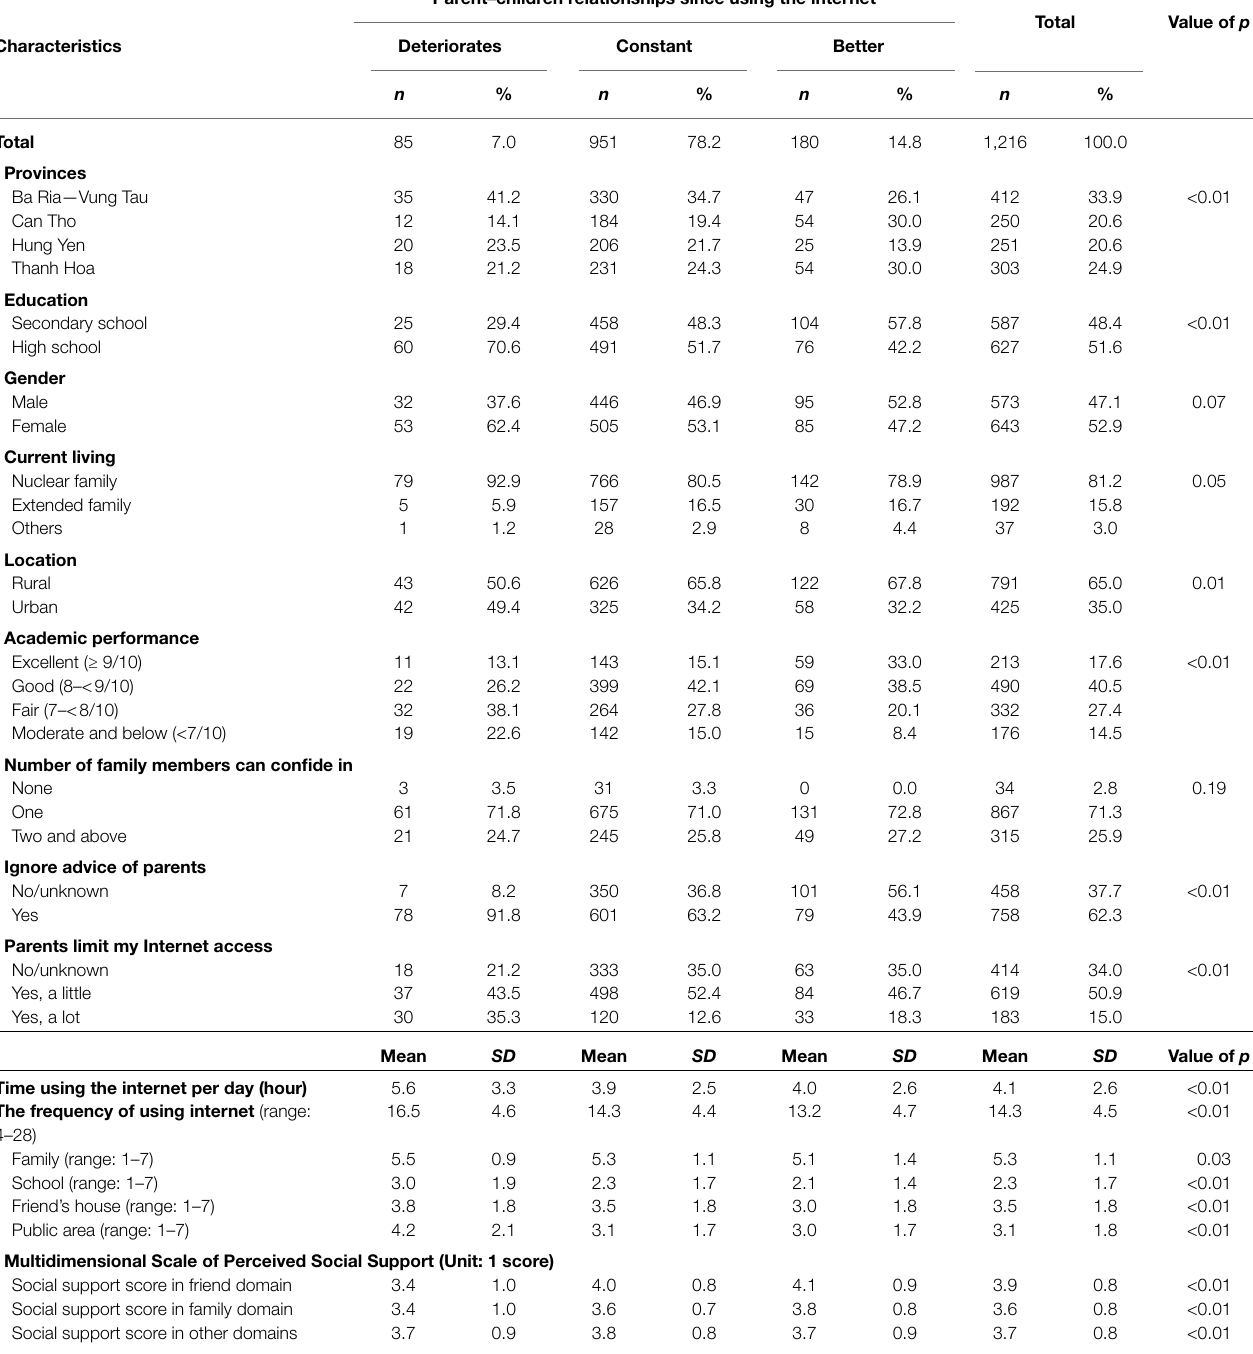
Parent–children relationships since using the